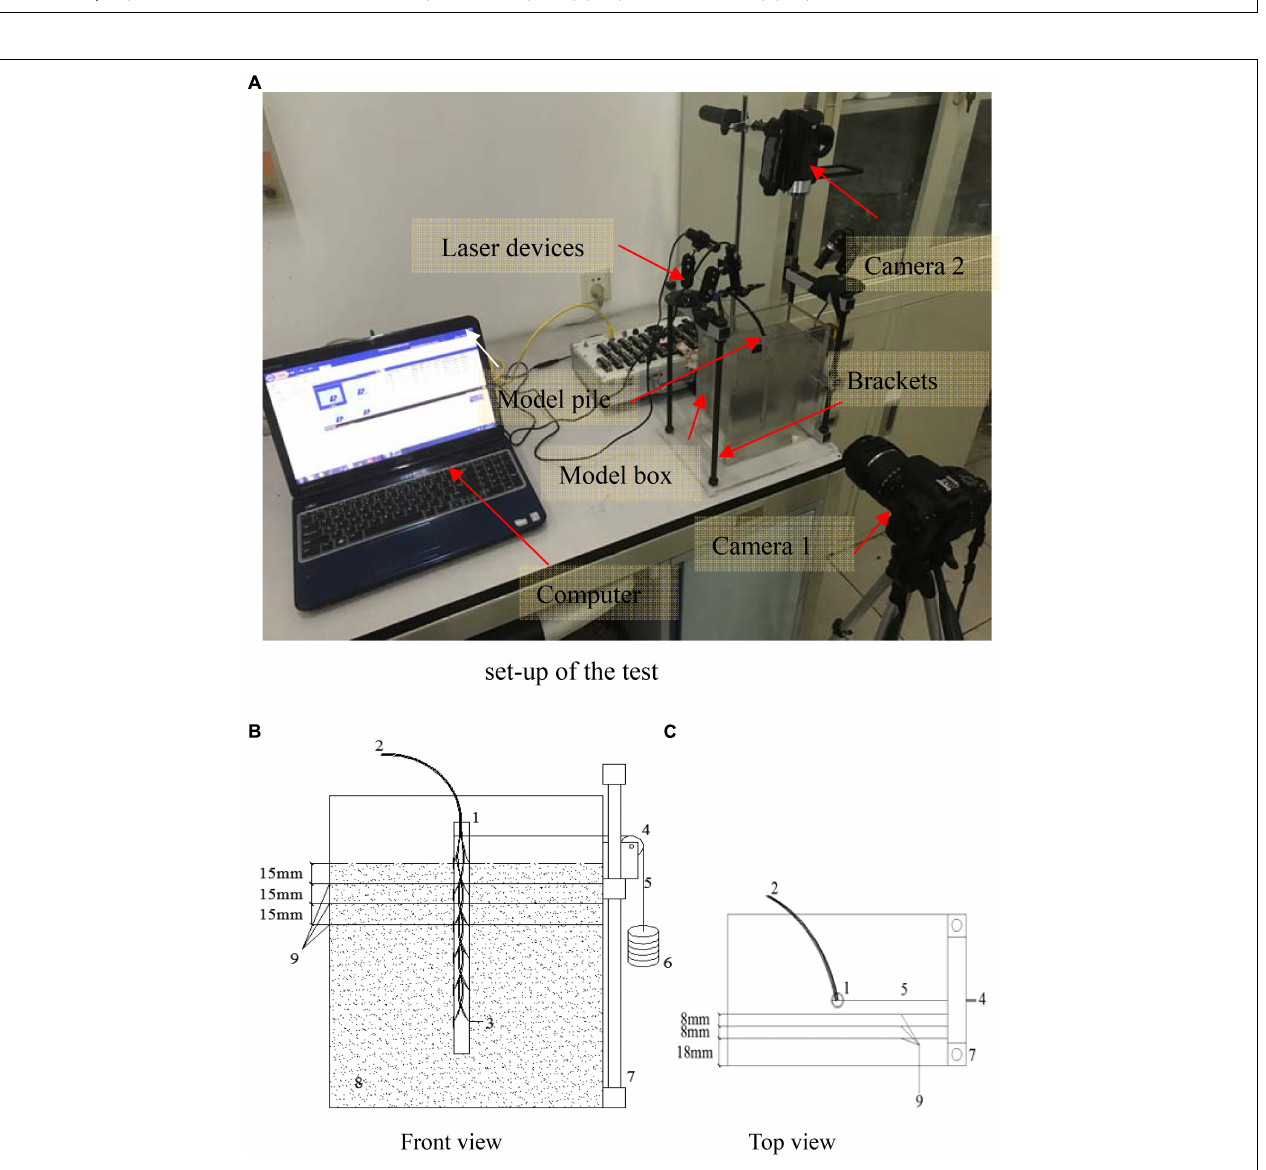
FIGURE 6 | Set-up of the 3D displacement field test: 1. model pile; 2. wire; 3. strain gauge; 4. pulley; 5. line; 6. weight; 7. bracket; 8. transparent soil; 9. laser irradiating surface. (A) Set-up of the test, (B) front view, and (C) top view.